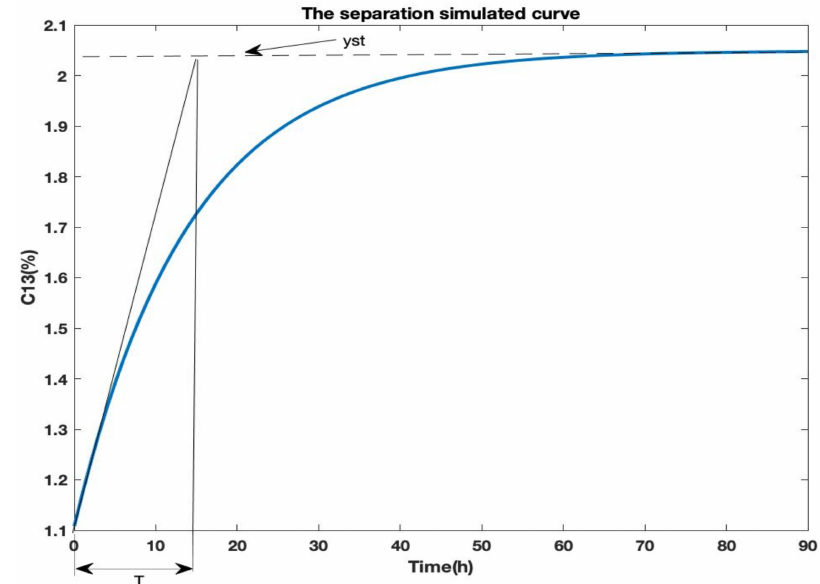
Figure 3. The tangent method—time constant